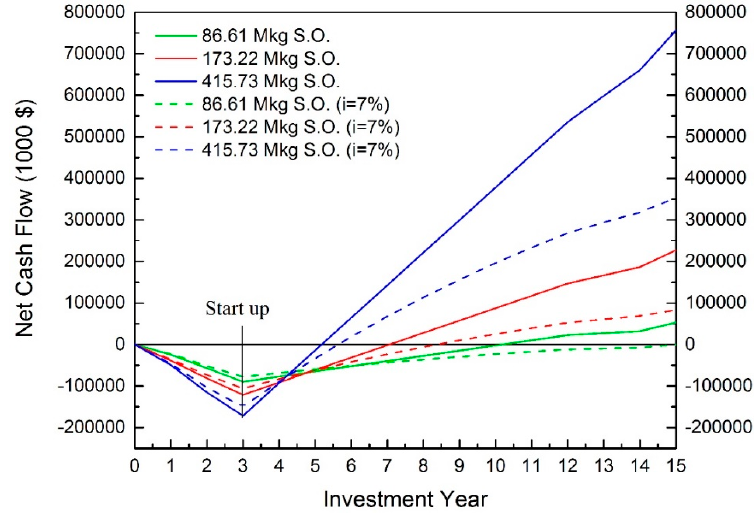
Figure 4. Cash flow of hexane extraction. (S.O. indicates the annual soybean oil production).